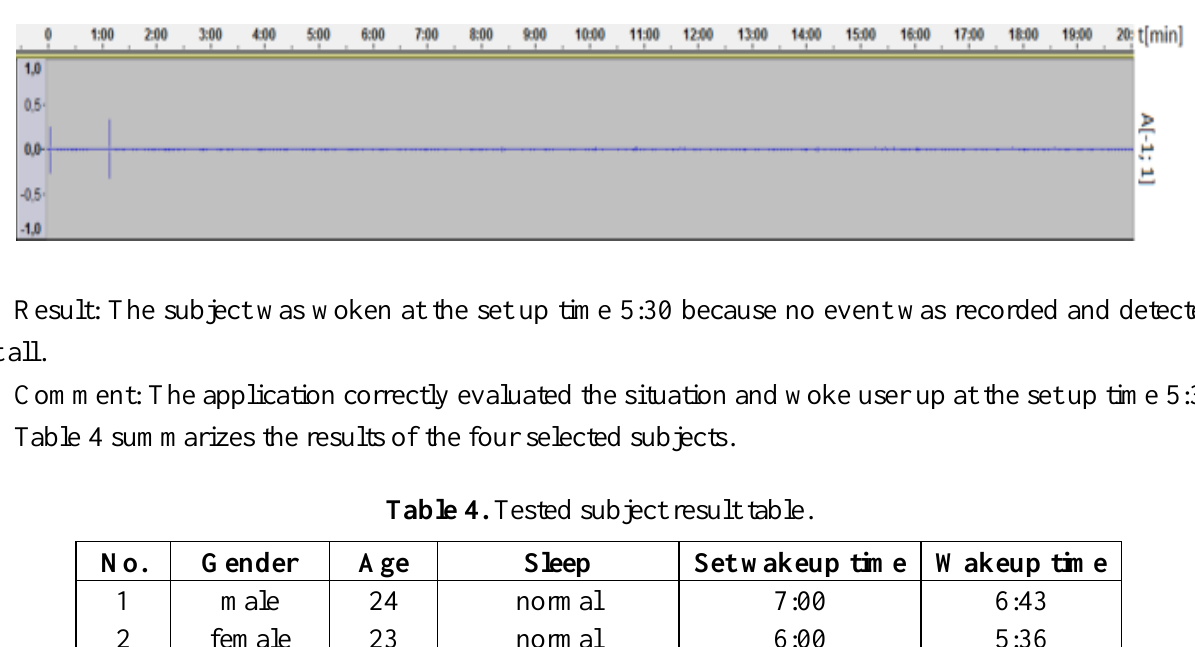
Figure 12. Recorded sound data of subject No.